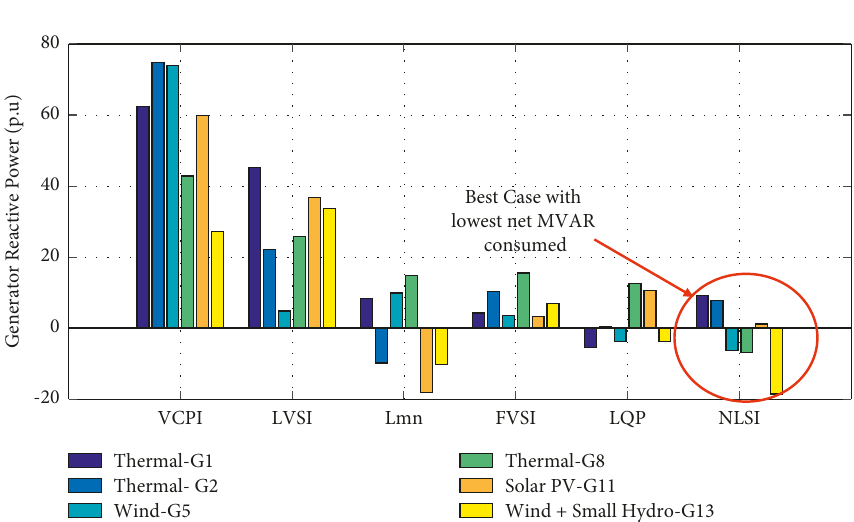
Figure 10: SC-2 Reactive power generation from the different